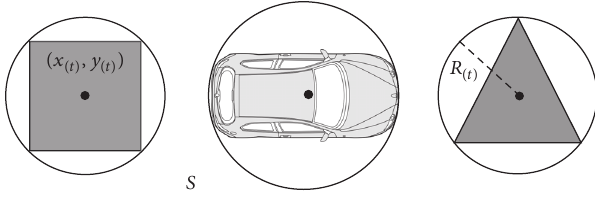
Figure 2: Example of